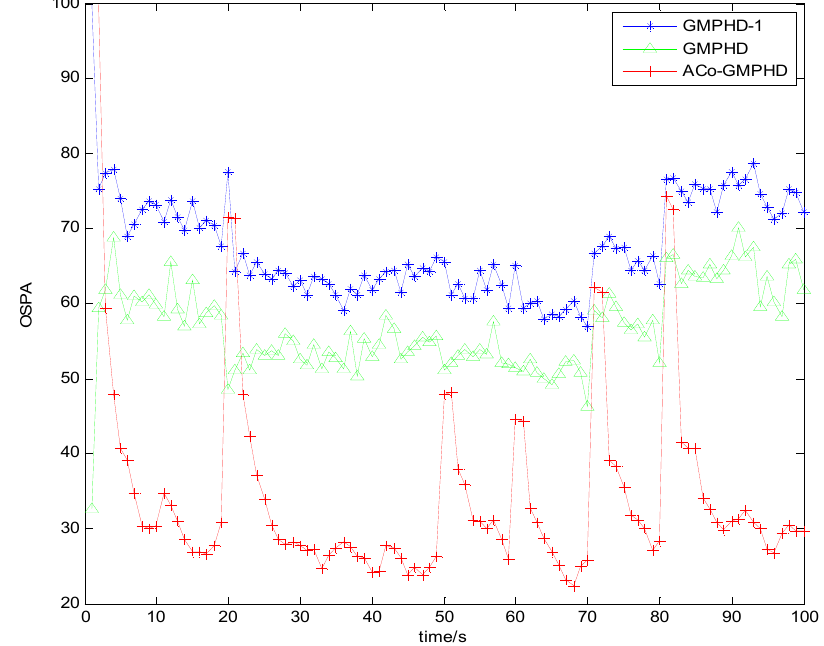
Figure 3. Monte Carlo average of the OSPA distance with a detection probability of 0.9.